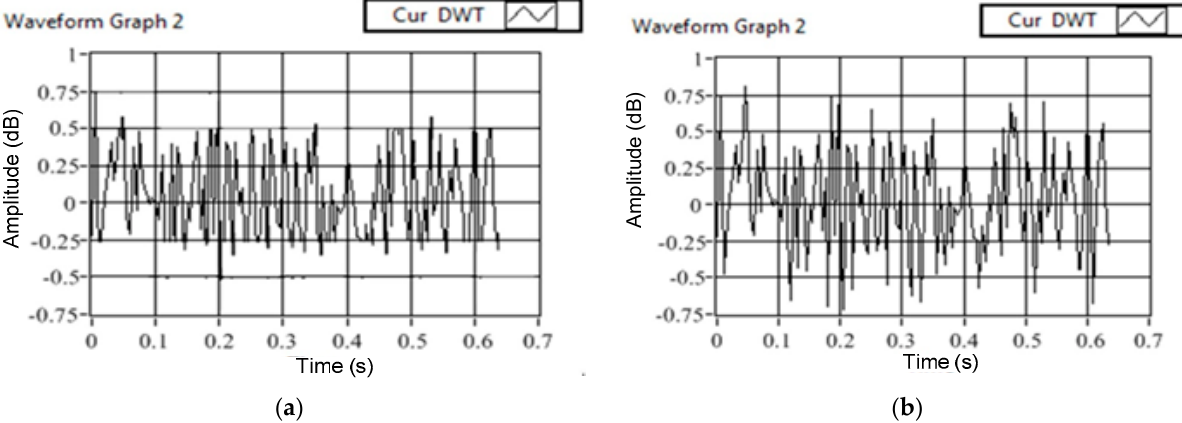
Figure 12. The [d 7 ] coefficient for SCIMs operating at a rated load torque obtained using the LabVIEW-based laboratory prototype under ( a ) healthy state, and ( b ) faulty state.